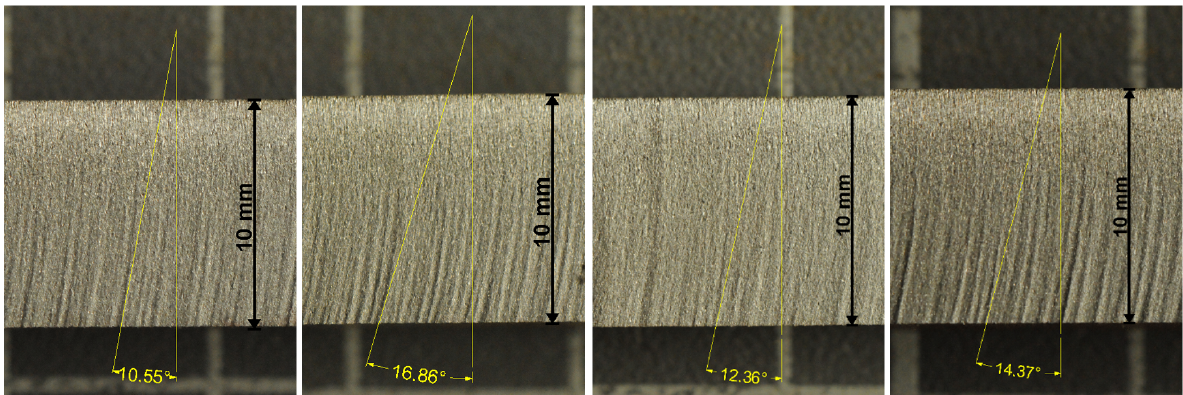
Figure 1. Steels and the respective average angles—the order from the left to the right (WRN norm): high strength steel (1.7131), tool steel (1.2436), stainless steel (1.4541), Hardox 500 (trademark of the SSAB).